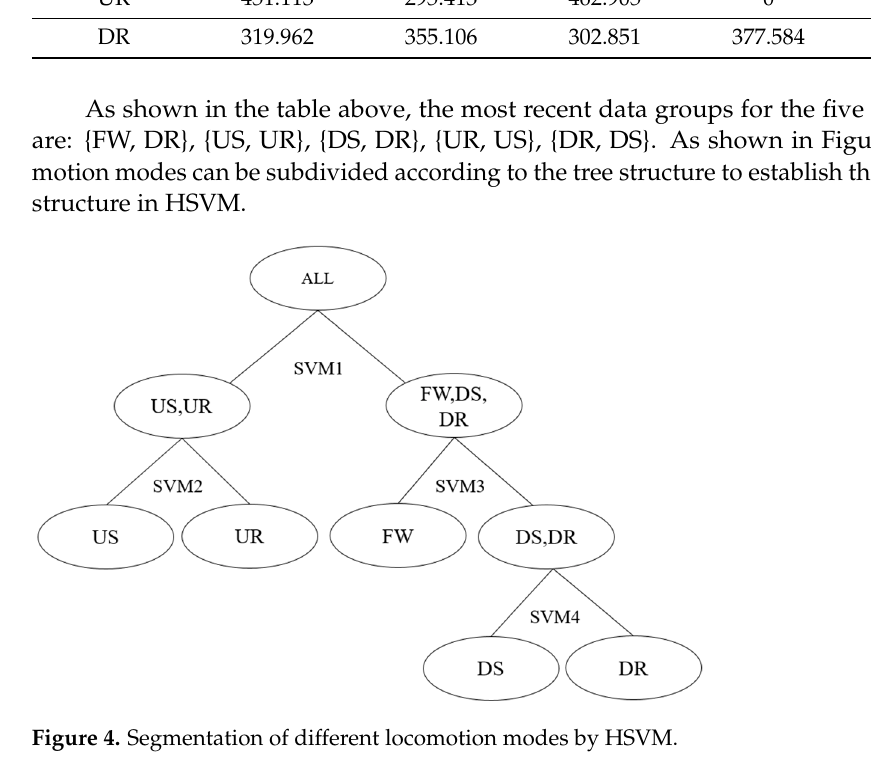
Figure 4. Segmentation of different locomotion modes by HSVM.